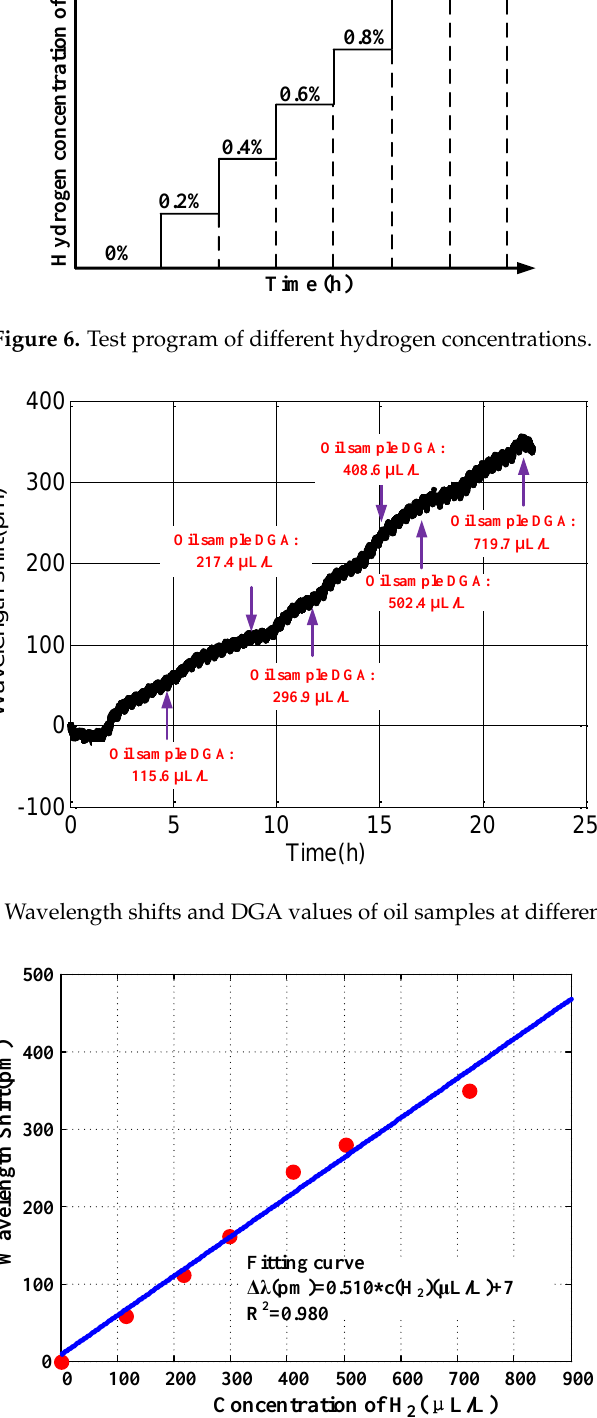
Figure 6. Test program of different hydrogen concentrations.